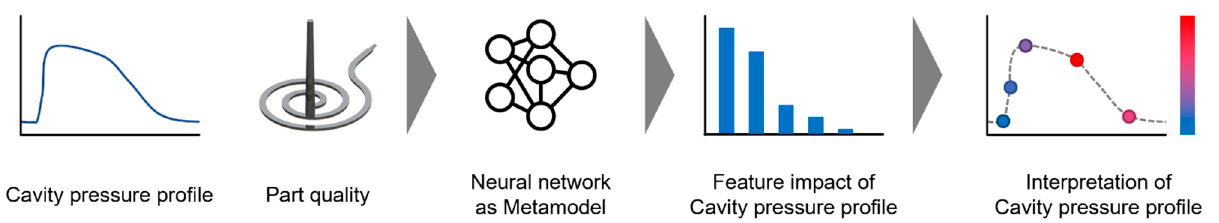
Figure 2. Schematic diagram of the proposed methodology.